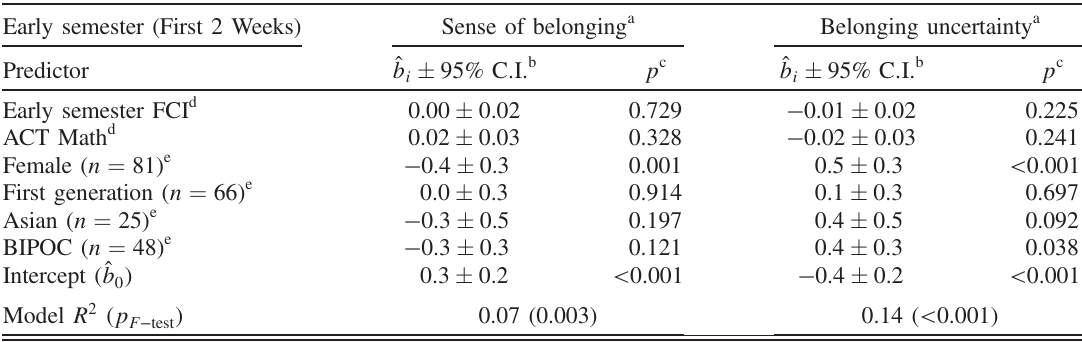
TABLE II. Early semester social belonging multiple regression